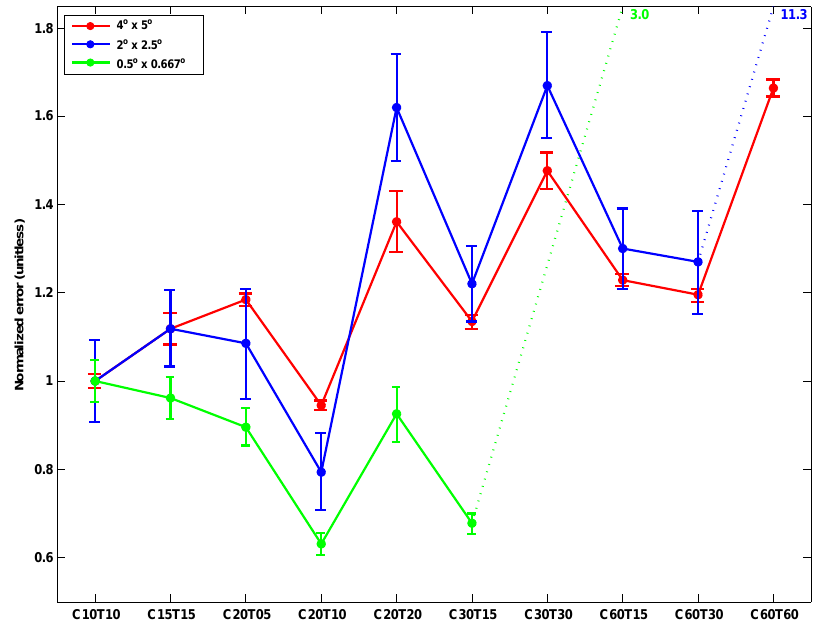
Figure 6. CPU-time adjusted composite normalized error (CNE, Eq. 4) for GEOS-Chem simulations with various horizontal resolutions and operator durations. Colored lines and dots represent the CNE for the global simulations at 4 ◦ × 5 ◦ (red) and 2 ◦ × 2.5 ◦ (blue), and the nested simulations at 0.5 ◦ × 0.667 ◦ (green) horizontal resolutions. Error bars represent standard error in CPU time. Simulations are represented in the abscissa as CccT tt with chemical operator duration, C = cc min, and transport operator duration, T = tt min. Table 1. Comparison of mean ∗ relative simulation error vs. horizontal resolution, with “truth” defined at 2 ◦ × 2.5 ◦ horizontal resolution. Species Mean relative simulation error (unitless) 4 ◦ × 5 ◦ resolution